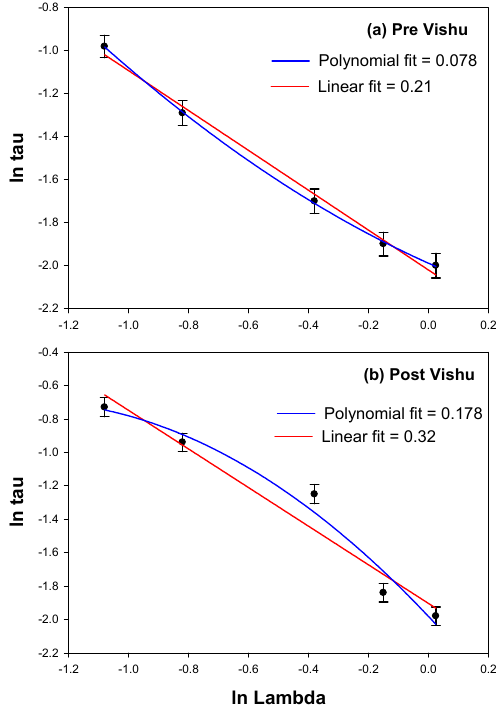
Figure 3. ( a ) ln λ vs. ln τ for pre-Vishu and ( b ) ln λ vs. ln τ for post-Vishu for the years 2015, 2016, 2017, and 2018. The vertical bar in the graph represents one sigma standard deviation.